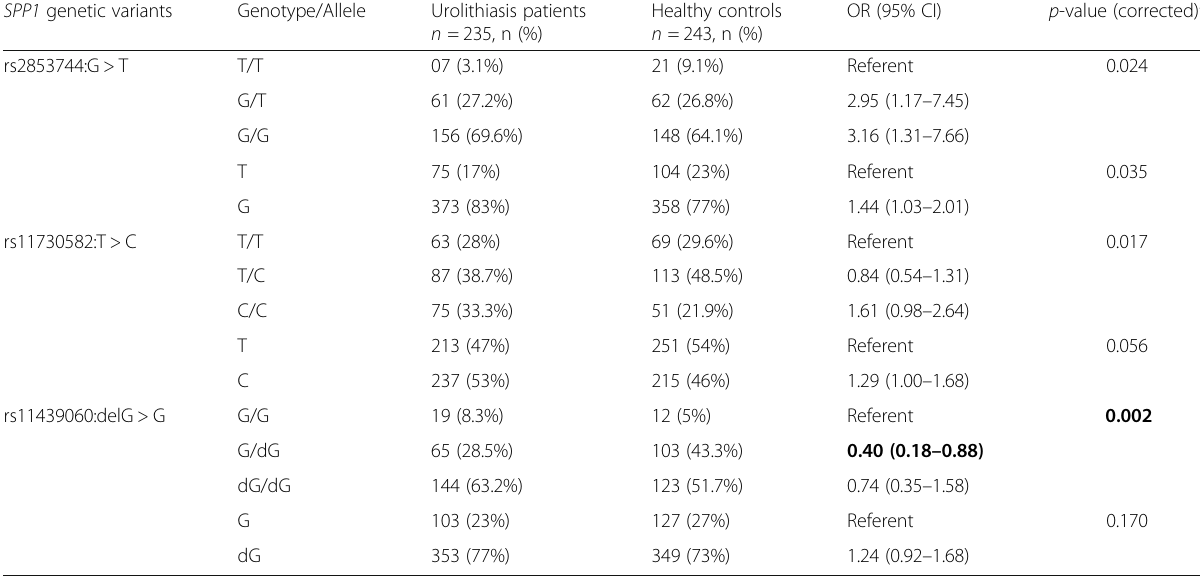
Table 1 Association analysis of urolithiasis risk and SPP1 genetic variants considering their allelic and genotypic frequencies SPP1 genetic variants